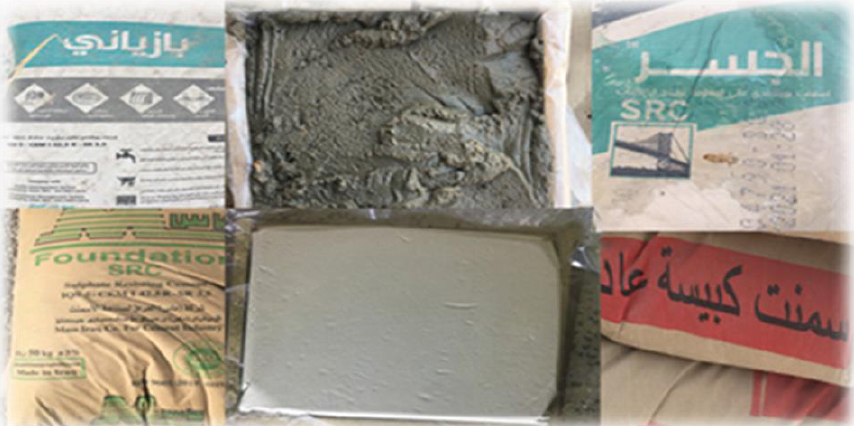
Figure 1: Some of the measured cement samples.